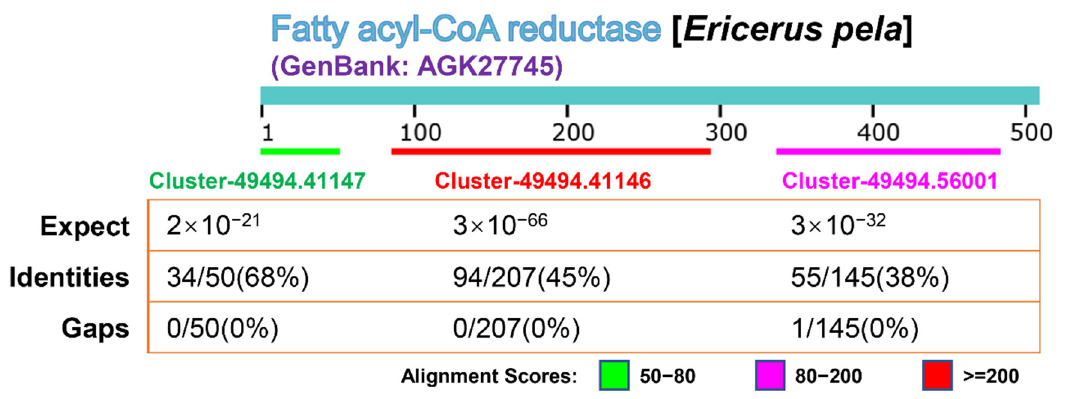
Figure 7. The results of the BLAST alignment of the three clusters annotated as FAR genes in the CWWS insect transcriptome and the reported FAR protein sequences in GenBank. The three clusters were aligned to three different positions in the FAR protein sequence (GenBankID: AGK27745). Comparison method: compositional matrix adjustment. Expect (E-value) indicates the possibility of random matching. The larger the E-value, the greater the possibility of random matching. When the E-value is close to zero or zero, it is a perfect match. Identities: The percentage of matched bases in the total sequence length. Gaps: Insertion or deletion.